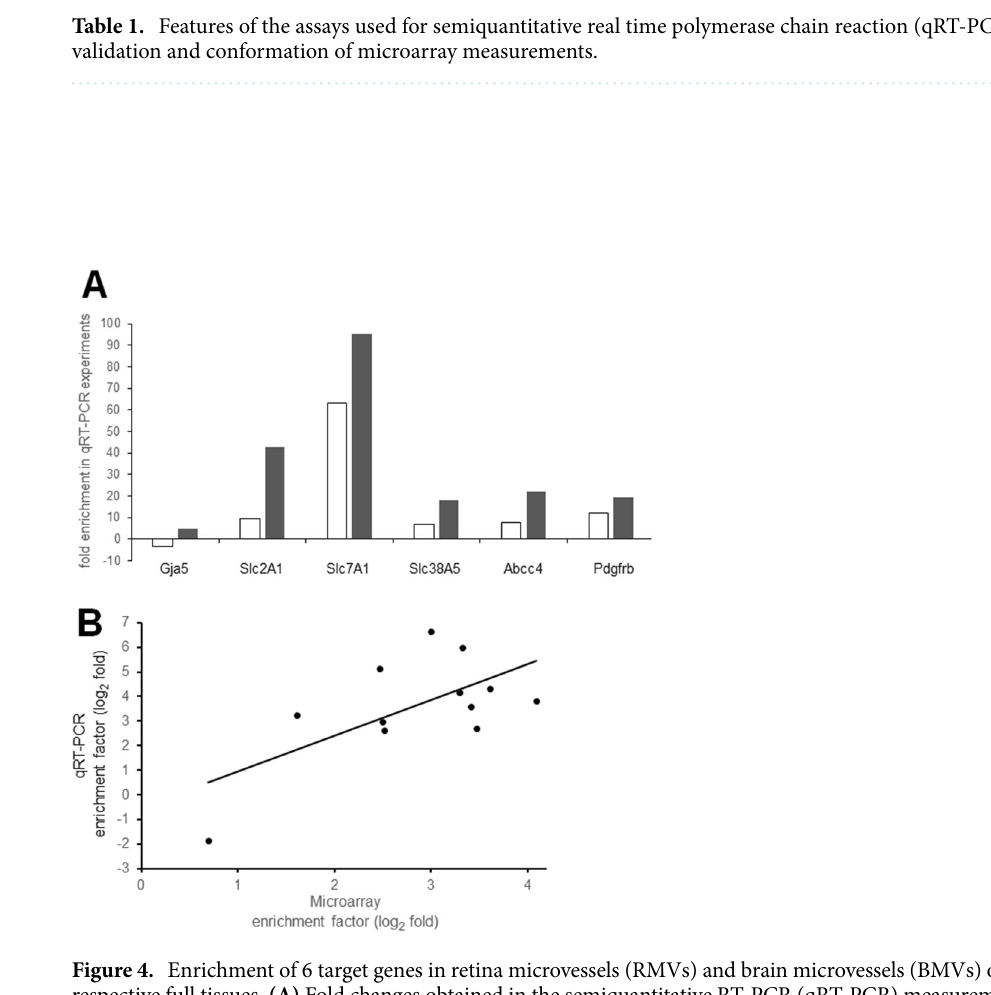
Figure 4. Enrichment of 6 target genes in retina microvessels (RMVs) and brain microvessels (BMVs) over the respective full tissues. (A) Fold changes obtained in the semiquantitative RT-PCR (qRT-PCR) measurements in RMVs (open bars) and BMVs (filled bars). Gja5, gap junction alpha-5 protein (also termed Cx40); Slc2A1, solute carrier family 2 member 1; Slc7A1, solute carrier family 7 member 1; Slc38A5, solute carrier family 38 member 5; Abcc4, ATP binding cassette subfamily C member 4; Pdgfrb, platelet derived growth factor receptor beta. (B) Agreement of results obtained by microarray measurements (abscissa) and qRT-PCR measurements (ordinate). In this graph enrichment is indicated as log 2 fold changes. The regression line and the corresponding correlation coefficient show the significant agreement of data obtained by the two